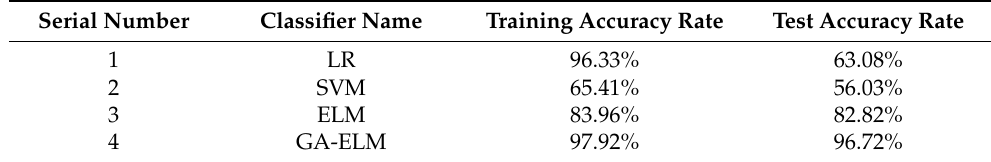
Table 2. The comparison of correct rates of different classifiers.